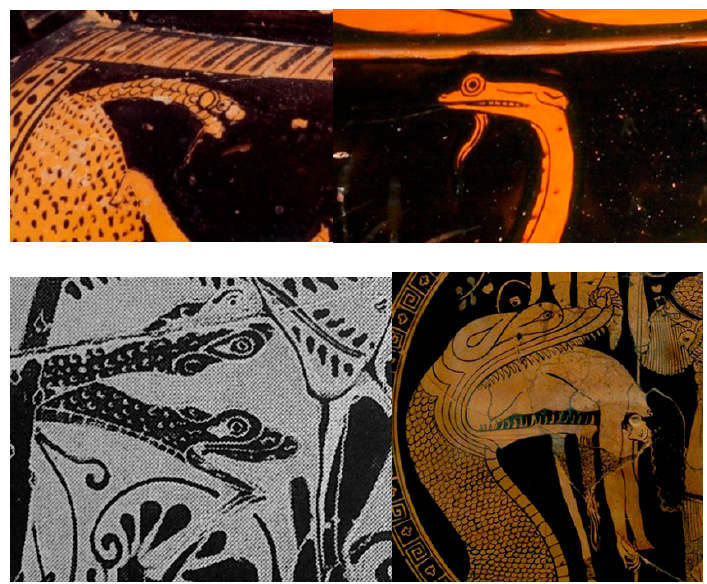
Figure 3. Clockwise: Detail of snake from red-figure column-krater with the scene of Jason and the Golden Fleece; attr. to the Orchard Painter; Attica; ca. 470 BCE (MMA acc. no. 34.11.7). Detail of snake from red-figure calyx-krater with the scene of Kadmos and the Serpent; attr. to the Spreckels Painter; Attica; ca. 450 BCE (MMA acc. no. 07.286.66). [Images courtesy of the open-access program of the Metropolitan Museum of Art, New York.] Detail of red-figure cup with the scene of Jason swallowed by the snake; signed by Douris; Attica (from Cerveteri); ca. 470 BCE (Rome, Museo Gregoriano Etrusco inv. no. 16545). Detail of snake from black-figure lekythos with the scene of Hera- kles in the Garden of the Hesperides; attr. to the Cactus Painter; Attica; ca. 500 BCE (Berlin, An- tikensammlung inv. no. 3261, lost). [Image after (Rodríguez Pérez 2015)]. Establishing the meaning of the words ophis and drak ō n , which were both used by ancient authors to refer to the ‘snake’, is not easy. On the basis of several scholia to Eurip- ides and Aeschylus 22 and of Euripides’ description of the snake of Ares in Bacchae 1025, as ‘a snake of the big-eyed type’, the distinction between a drak ō n and a snake has been traditionally explained as a species/genus relationship, i.e., ophis would be the genus of which drak ō n is a species . Bodson (1981, pp. 63–67) thought that drak ō n referred to a partic- ular species of snake of the family Colubridae , mostly non-venomous animals whose main characteristic is their acute vision and particularly hypnotic and expressive eyes. 23 Nev- ertheless, Sancassano (1996) and Riaño (1999) have rightly contested this theory. In fact, ancient authors used the word drak ō n in the same ways that they used ophis : to refer to the mythical snakes of the combat myth and to the snakes of their natural surroundings. Riaño has surveyed the occurrences of both terms—285 of ophis and 138 of drak ō n —in ancient literature from Homer to Aristotle, and from his study it emerges that when authors use drak ō n to refer to a non-mythical snake, the word is used as a synonym of ophis . But, while there is no zoological difference between the animals called drak ō n and ophis in ancient literature, there is indeed a qualitative distinction: drak ō n is used for snakes regarded as extremely frightening and dangerous, in particular those featured in myths. It refers to the kind of snakes we encounter in the combat myths: extraordinary monsters of great size, frightening look and reputed keen vision, sleepless 24 and old, whose origin was not always clear but which were in a close partnership with the Earth or were the offspring of likewise uncanny creatures born in the earliest stages of development of the 22 Schol. Eur. Or . 479; Schol. Aischyl. Sept . 291.a; Schol. Aischyl. Sept . 381.c. 23 Ogden (2013, pp. 2–5), for his part, loosely employs ‘ drak ō n ’ as synonym with ophis and serpens , and ultimately does not distinguish ‘snake’, ‘serpent’ or ‘dragon’. 24 A biological trait of snakes is undoubtedly behind this consideration: their lidless, unblinking eyes, which are protected only by a transparent scale. Either awake or asleep the eyes of the serpents always remain the same, as if in an eternal wakefulness.